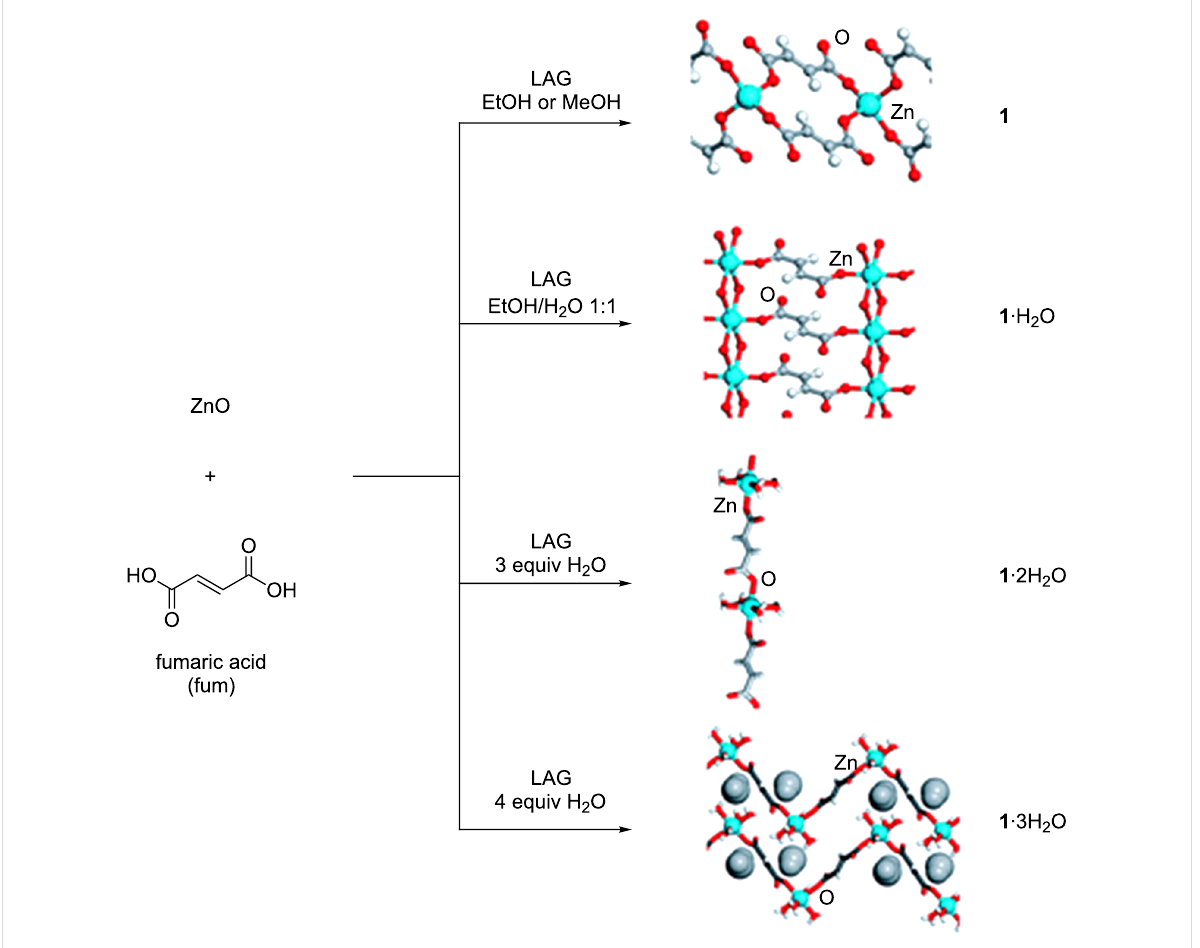
Figure 4: Mechanochemical syntheses of coordination polymers from ZnO and fumaric acid. Reprinted with permission from [137], copyright 2010 the Royal Society of Chemistry.